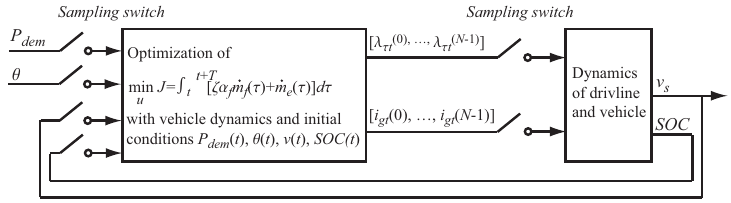
Figure 10. Schematic diagram of the nonlinear MPC (NMPC)